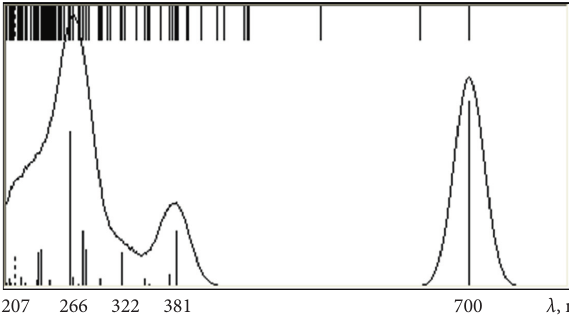
Figure 3: The calculated absorption spectrum of PMD-II. Table 4: Calculated absorption spectrum of